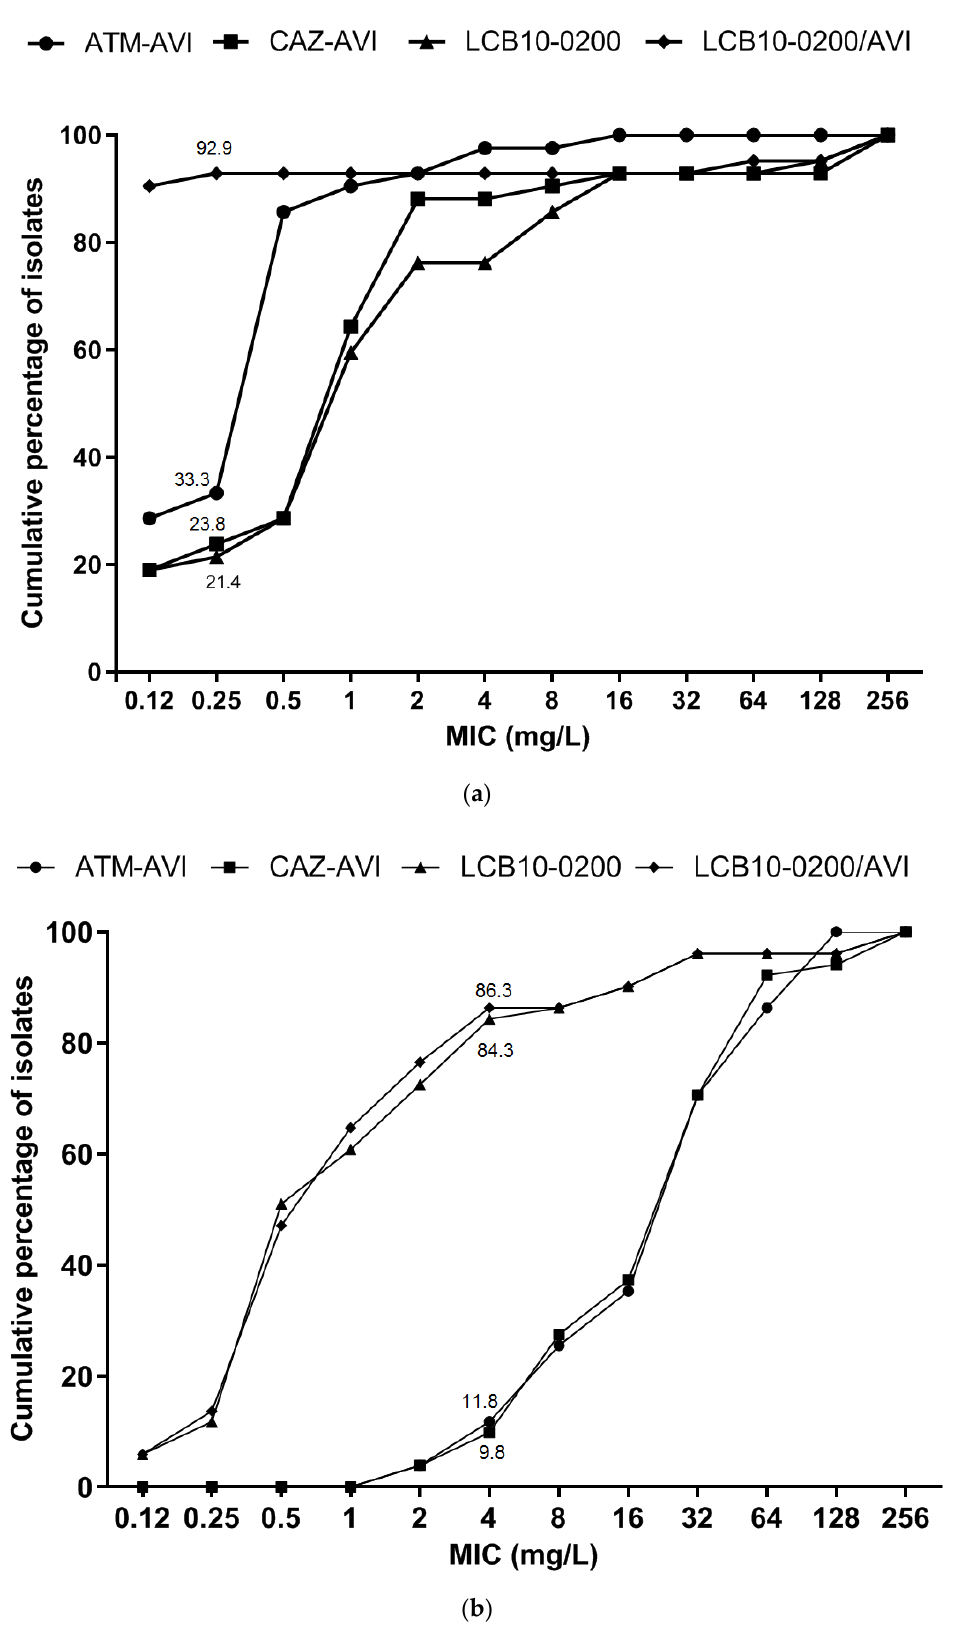
Figure 2. Distribution and cumulative percentages of tested isolates for ( a ) carbapenem-resistant E. coli and K. pneumoniae ( n = 42), and ( b ) A. baumannii and P. aeruginosa ( n = 51).